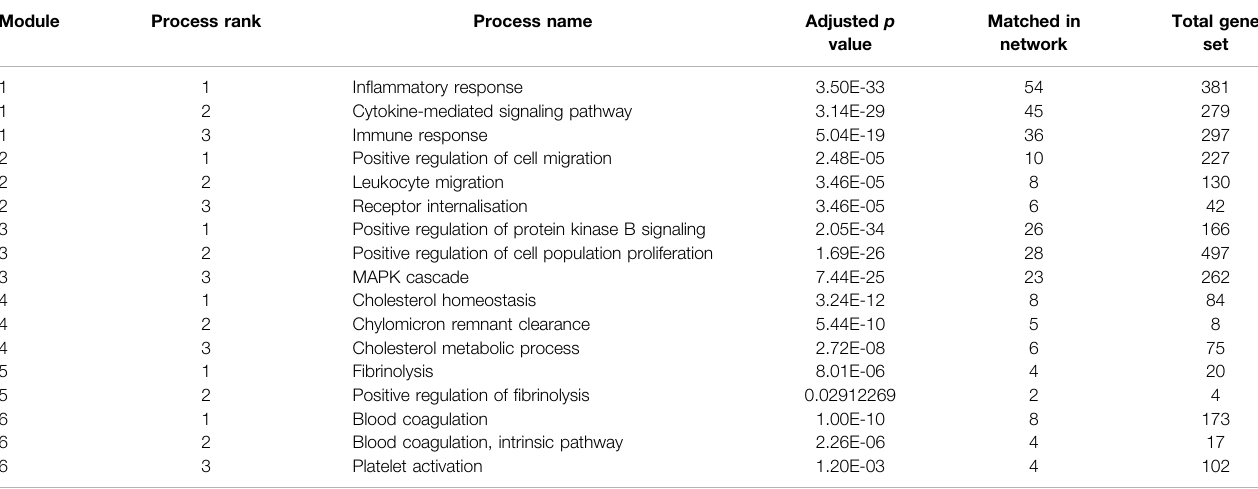
TABLE 6 | Biological process enrichment for the six largest modules in the initial network.